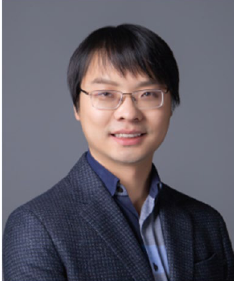
of quantum-logic operations that are described by uni- tary matrices. He has also made impactful contributions to acoustic metamaterials, demonstrating the excellent sound-proofing capabilities of metamaterials. Dr. Ma later used absorptive metamaterials to break the focusing diffraction limit in three dimensions. Recently, he blurred the boundary between solids and fluids by first demon- strating fluid-like elasticity in a solid-based mechanical metamaterial and conversely realized transversality and spin-orbit interactions in a fluid-acoustic system.